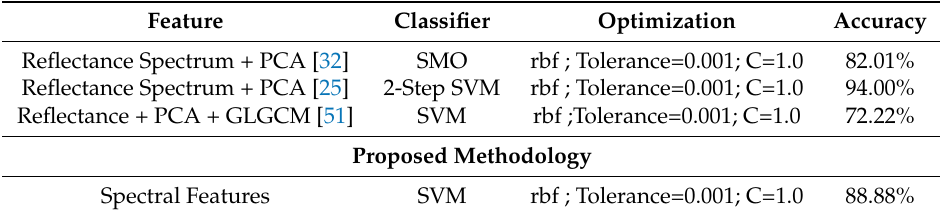
Table 6. Comparative results with the state-of-the-art methods using same test